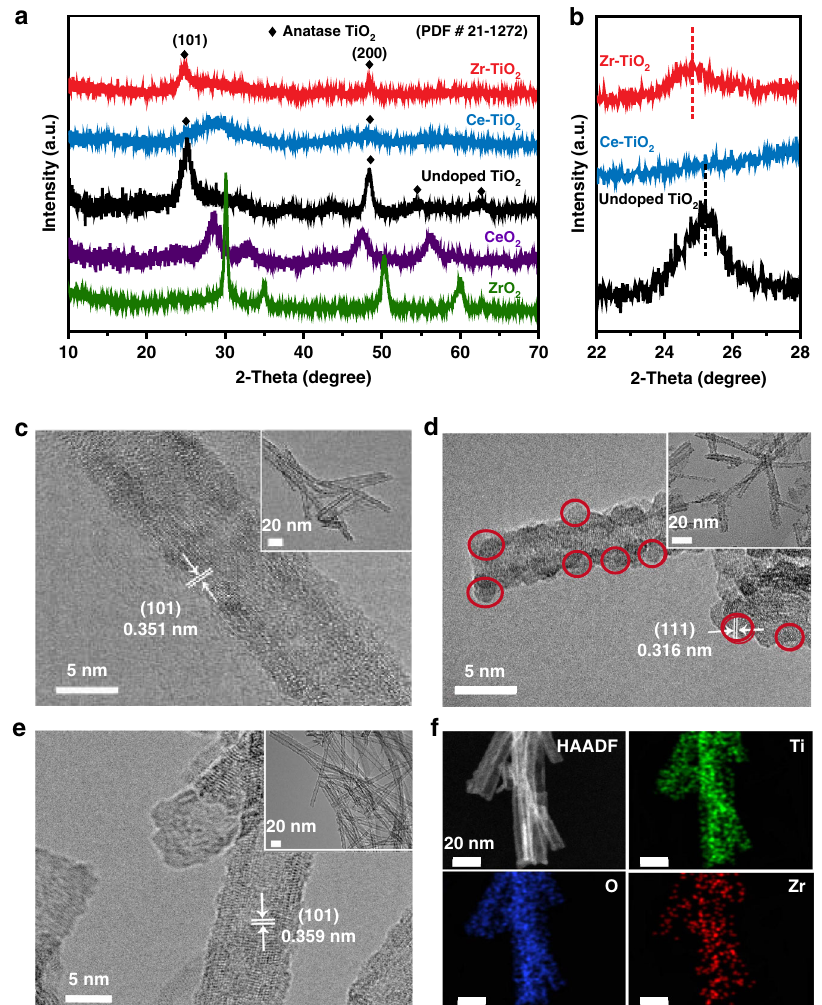
Fig. 4 Structural and compositional characterizations. a X-ray diffraction (XRD) patterns of ZrO 2 , CeO 2 , undoped TiO 2 , Ce-TiO 2 , and Zr-TiO 2 . b The enlarged view of XRD pattern at 22 o − 28 o range. c – e High-resolution transmission electron microscopy (HRTEM) images of c undoped TiO 2 , d Ce-TiO 2 , and e Zr-TiO 2 samples. Insets: Transmission electron microscopy (TEM) images of the corresponding nanotubes. f High-angle annular dark- fi eld scanning transmission electron microscopy (HAADF-STEM) image with corresponding element mappings of Zr-TiO 2 , showing the distribution of Ti (green), O (blue), and Zr (red). (Source data are provided as a Source Data fi